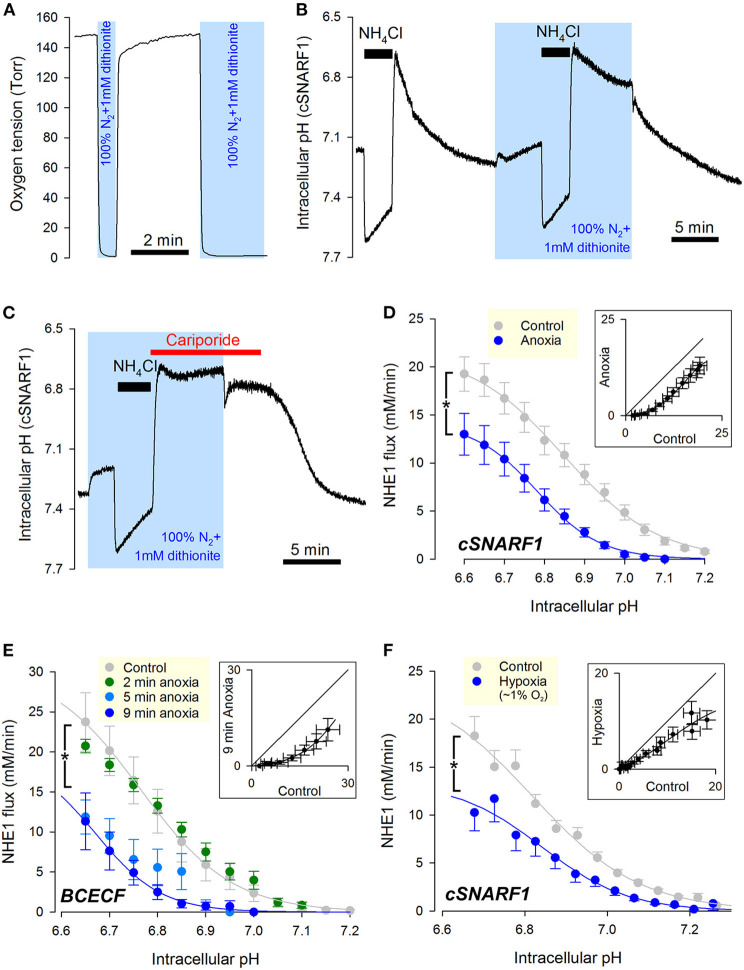
Cardiac NHE1 activity is rapidly inhibited by acute anoxia. (A) Measurement of oxygen tension in the superfusion chamber, showing anoxic conditions are attainable by solutions bubbled with N2 and supplemented with the oxygen-scavenger dithionite (1 mM). (B) Exemplar trace of paired ammonium prepulses, first performed in normoxia and then in anoxia, in a rat ventricular myocyte loaded with cSNARF1. Recovery of pHi from the acid load is greatly attenuated under anoxic conditions, but becomes re-activated upon re-oxygenation. (C) Exemplar time course showing lack of background acid-loading at low pHi under anoxic conditions, revealed in the presence of cariporide (30 μM) to block NHE1. (D) NHE1-generated H+-flux measured by cSNARF1 or (E) BCECF in normoxia (cSNARF1: n = 22 cells from 5 rats; BCECF: n = 9 cells from 4 rats) or 9 min anoxia (cSNARF: n = 9 cells from 2 rats; BCECF: n = 7 cells from 2 rats). In the case of BCECF experiments, the effect of anoxia was also tested after 2 min exposure (n = 5 cells from 3 rats), 5 min exposure to anoxia (n = 5 cells from 3 rats). Two-way ANOVA: effect of 9 min anoxia vs. control was significant (P < 0.0001 for cSNARF1 and P < 0.01 for BCECF datasets); effect of 5 min anoxia vs. control was significant (P < 0.0001); effect of 2 min anoxia was not significant (P = 0.93). Interaction between pH and treatment was not significant in any of the cases; the effect of pHi was significant (P < 0.0001 for all datasets). Insets plot flux in anoxia (9 min) vs. normoxia for matching pHi; the parallel shift is indicative of a change in affinity. (F) Effect of 15 min 3 Torr hypoxia (~1% O2) attained by including 0.1 mM dithionite in N2-bubbled solutions. Data recorded with cSNARF1. NHE1 activity was inhibited by hypoxia (n = 26 cells, 3 rats) relative to controls (n = 55, 3 rats). Two-way ANOVA: significant effect of hypoxia (P < 0.001); of pHi (P < 0.0001); and interaction (P < 0.0001). Inset plots flux in anoxia vs. normoxia for matching pHi. The observed parallel shift is indicative of a change in affinity.